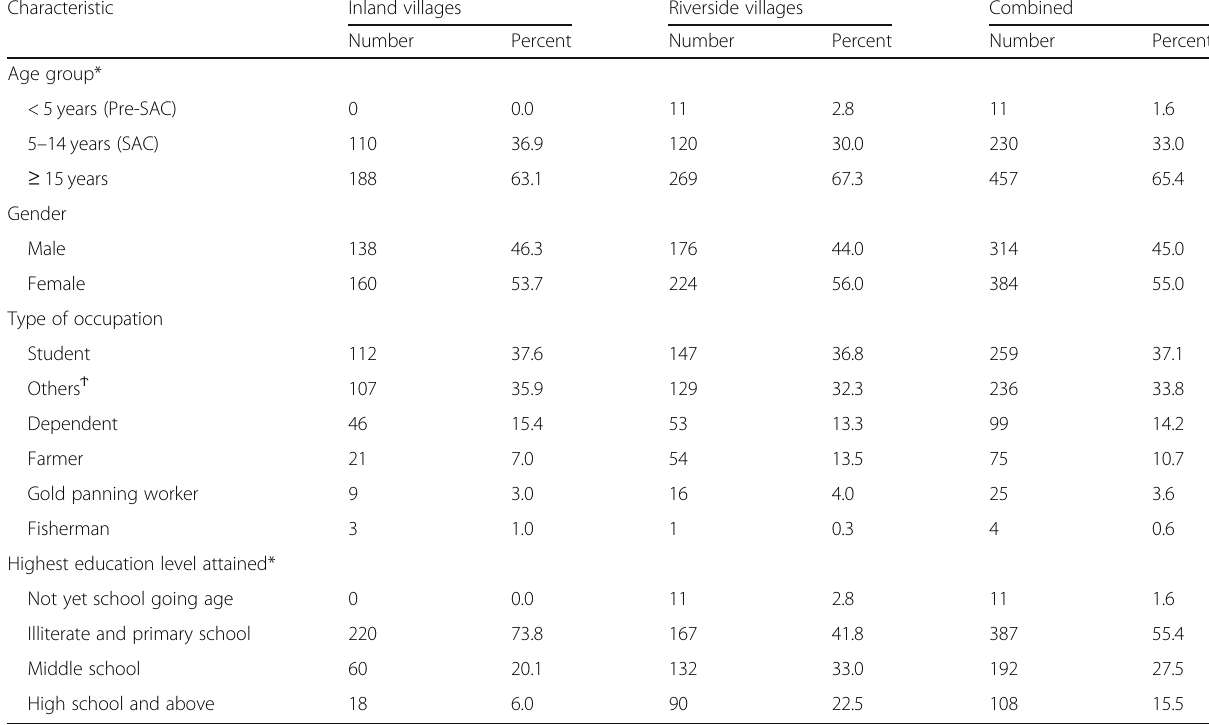
Table 1 Demographic and social characteristics of study participants in selected households in Shwegyin Township, Myanmar, 2017 ( n = 698) Characteristic Inland